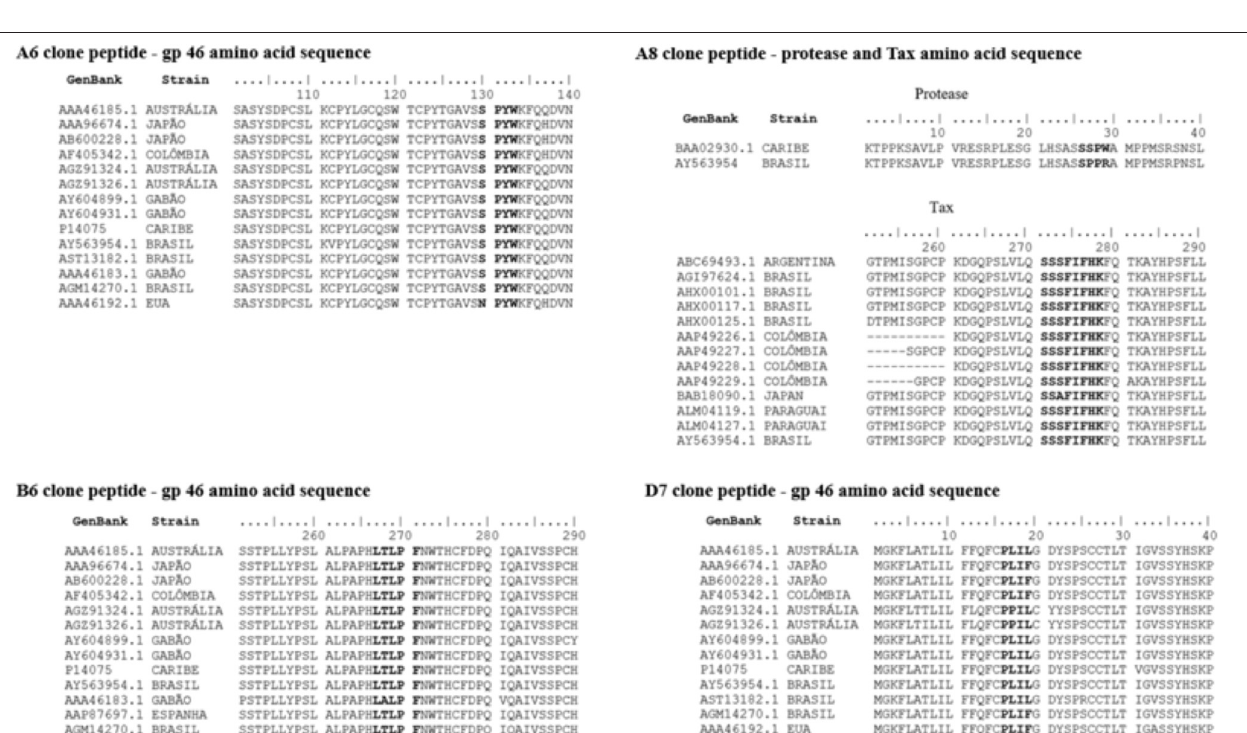
Frontiers in Medicine |